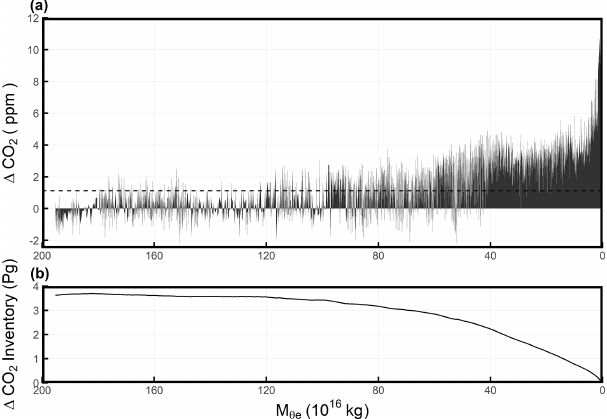
Figure 11. (a) Detrended CO 2 measurements from HIPPO-1 South- bound (from 12 to 17 January 2009) plotted as a function of M θ in e the Northern Hemisphere. The data are detrended by subtracting the MLO stiff cubic spline trend. Individual points are connected by straight line segments, and the area under the resulting curve is shaded. We note that the area under the curve has units of parts per million × kilograms, and dividing this by the total dry air mass (i.e., the range of M θ of the integral) gives the parts per million unit e because the mass of dry air is proportional to the moles of dry air. The Northern Hemisphere average of 1.13ppm is indicated by the dashed line. (b) Integral of the data in panel (a) , rescaled from parts = 0 to a given M θ per million to petagrams, integrating from M θ e e